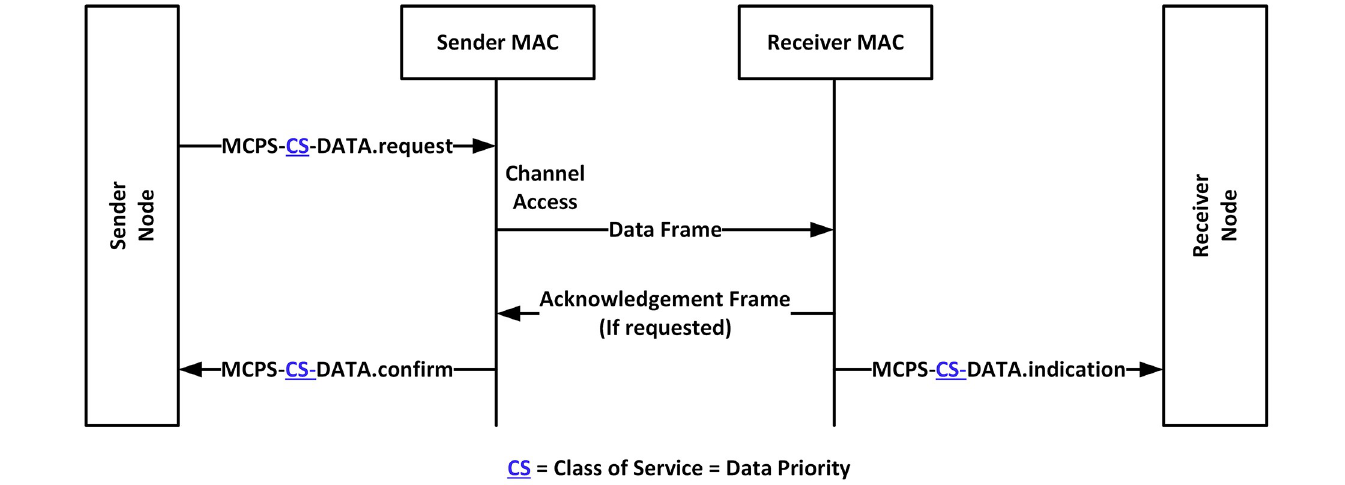
Fig 5. CSTP-MAC data service with data priority request.